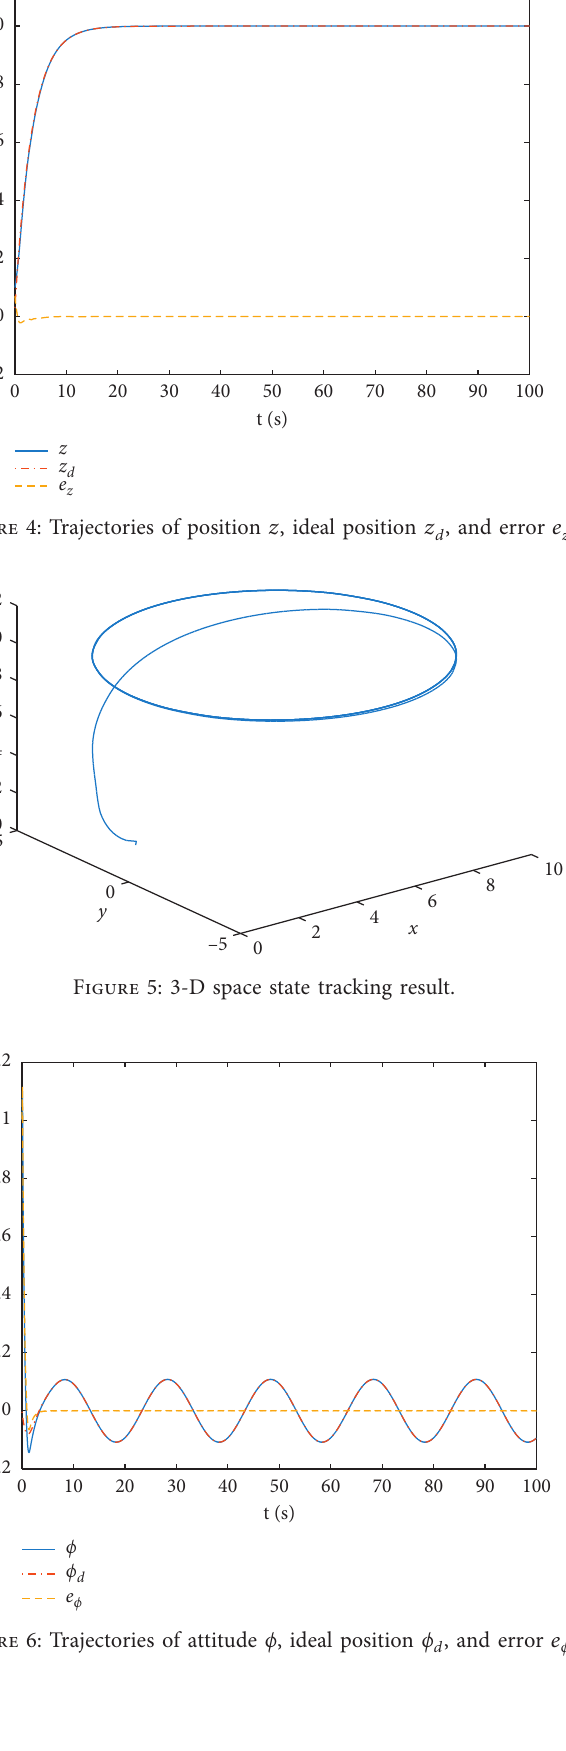
e d , and error ϕ